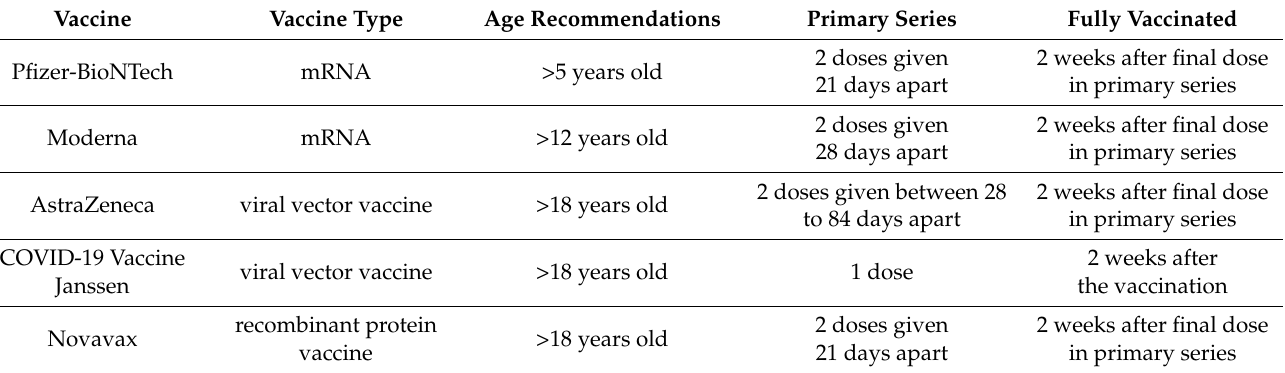
Table 1. COVID-19 Vaccination Schedule and